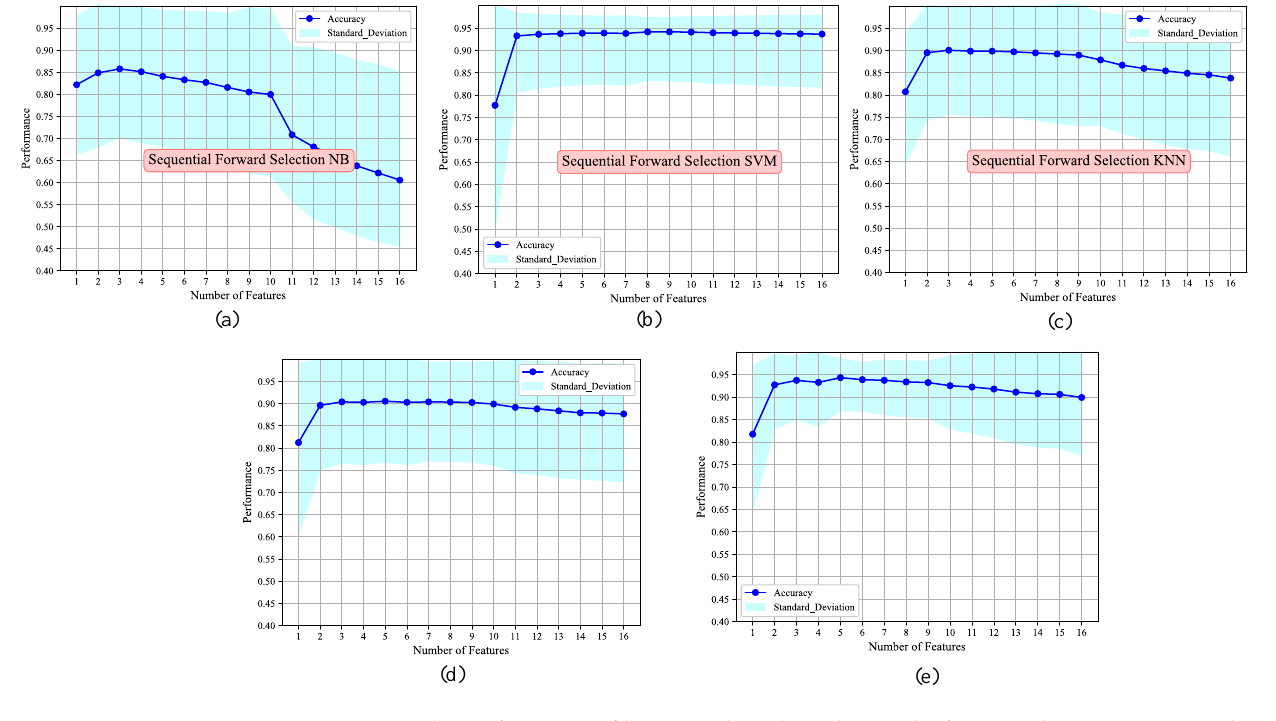
Figure 15. The performance of learning algorithms during the feature selection process in the FD layer, ( a ) NB classifier, ( b ) SVM classifier, ( c ) KNN classifier, ( d ) EN classifier with majority vote, and ( e ) the proposed method. Table 7. Validation results of the FD